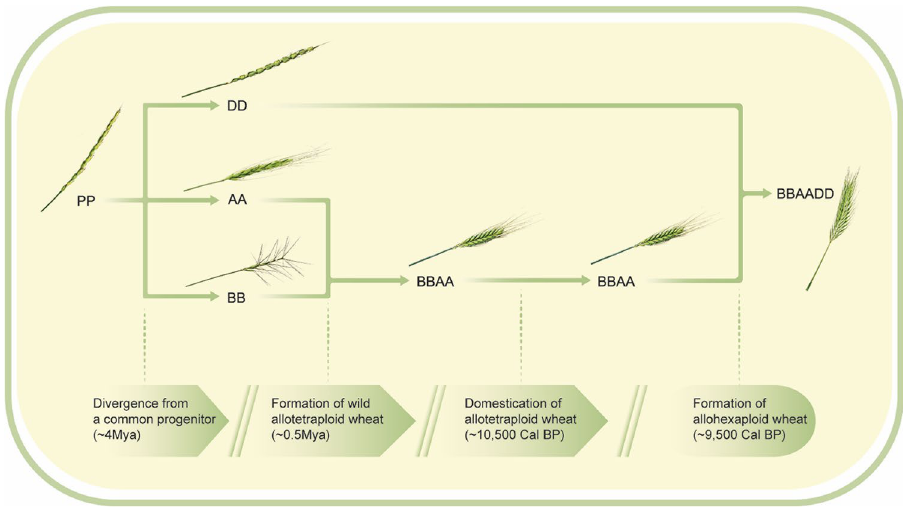
Figure 1. Evolutionary history of allotetraploid and allohexaploid wheat: Diploid wheats (2n = 2X = 14), from the Tritcum-Aegilops group have diverged ~ 4Mya from a diploid progenitor whose genome is indicated here as PP. Intergeneric hybridization between the diploid T. urartu (genome AA) as male and the donor of BB genome as female, (an unknown species similar to Ae. speltoides), followed by chromosome doubling, gave rise (~ 0.5Mya) to the wild allotetraploid wheat, Triticum turgidum ,ssp. dicoccoides (genome BBAA, 2n = 4x = 28), the direct progenitor of durum and bread wheat. Domestication of allotetraploid wheat took place ~ 10,500 years ago and was followed by a second round of intergeneric hybridization chromosome doubling between domesticated allotetraploid wheat and the donor of the D genome, Ae. Tauschii (2n = 2X = 14, genome DD), giving rise, ~ 9000 years ago, to bread wheat, an allohexaploid (2n = 6X = 42, genome AABBDD).